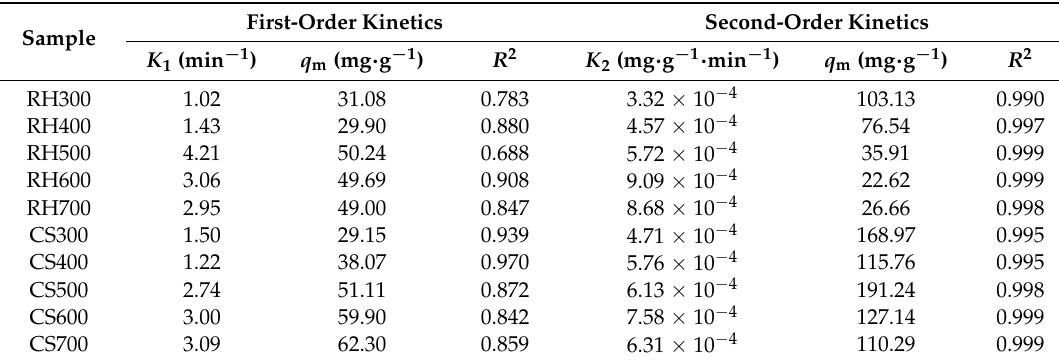
Figure 7. Second-order kinetics analysis for Cd 2+ adsorption by both sets of biochar samples. Notes: RH300, RH400, RE500, RH600, and RH700 indicate that rice husk were pyrolyzed at 300, 400, 500, 600 and 700 °C, respectively; CS300, CS400, CS500, CS600, and CS700 indicate that cotton straw were pyrolyzed at 300, 400, 500, 600 and 700 °C, respectively. Table 4. Kinetic parameters of Cd 2+ removal by both sets of biochar samples.